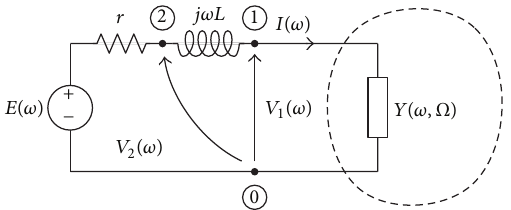
Figure 3: Example test circuit used for illustrating the proposed MNA formulation. The values defining the LTI series elements, that are characterized by their frequency-domain impedances, are 𝑟 = 10 Ω , 𝐿 = 1 mH. The PSL block highlighted by the dashed frame is the two-terminal PSL resistive block of Figure 2, where 𝑅 = 100 Ω and the switch 𝑆 has a periodic switching activity at frequency 𝑓 𝑐 = 10 kHz. The independent DC voltage source 𝑒(𝑡) = 10 V is defined in frequency-domain as 𝐸(𝜔) = 10/2𝜋𝛿 (𝜔)